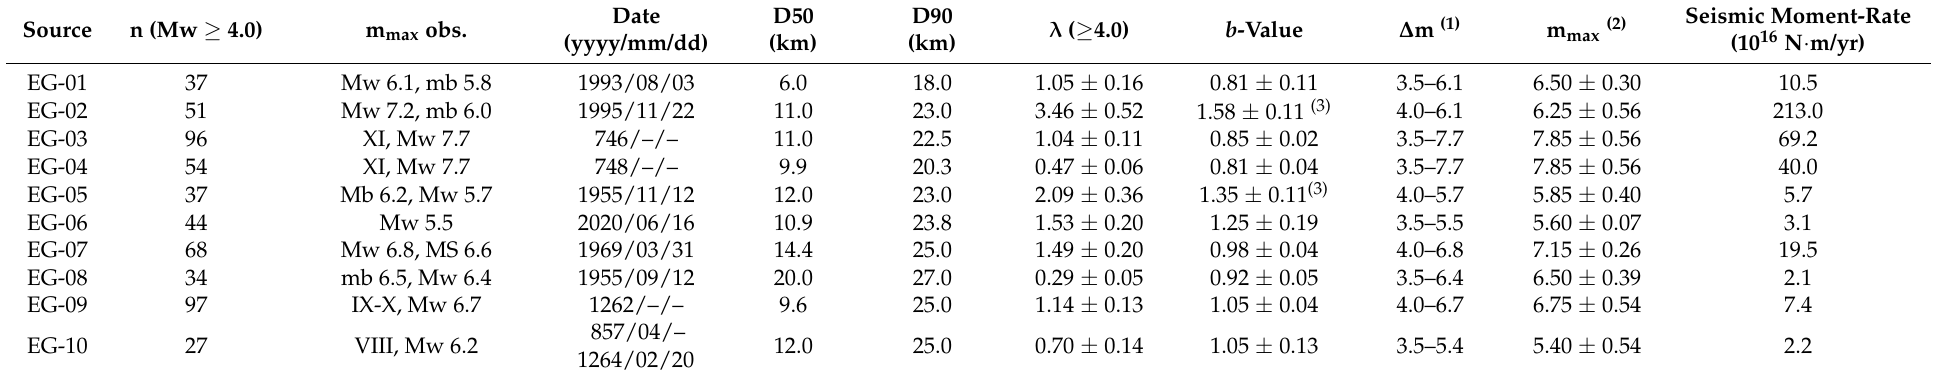
Table 2. Number of earthquakes (Mw ≥ 4.0), maximum recorded/observed magnitudes, D50 and D90 depth values, activity rates ( ≥ Mw 4.0), and b -values of the Gutenberg–Richter relationship, maximum expected magnitudes ( m max ), and the estimated seismic moment-rates for the proposed seismic sources. See the text for more